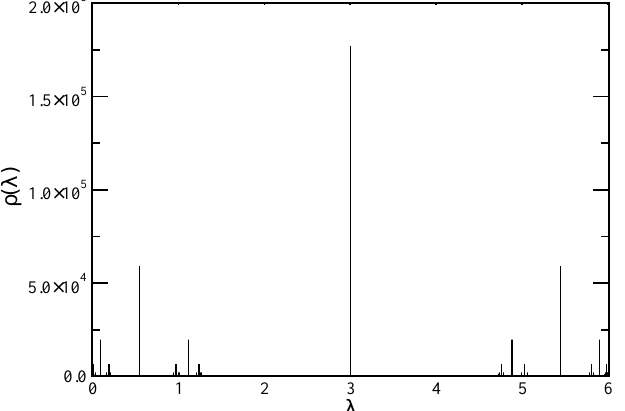
Figure 2. Histogram of the eigenvalues of the connectivity matrix A for the fractal cactus network of size N = 3 12 . The width of the bins is